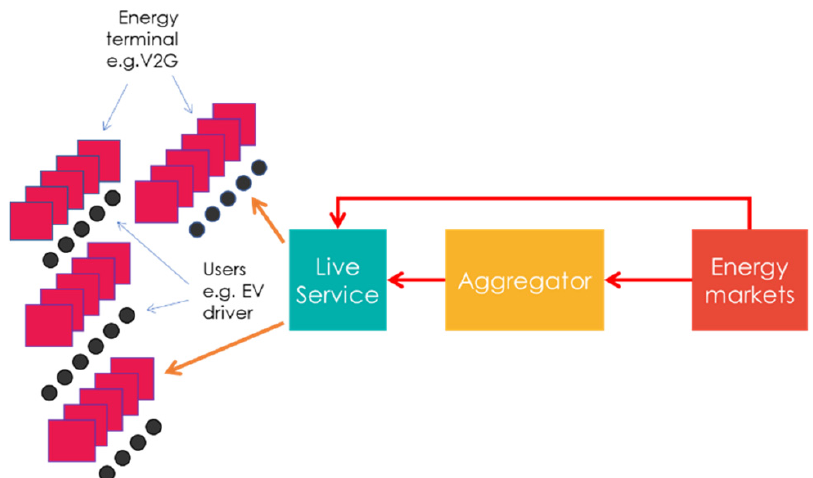
Figure 1. Live Service system diagram.